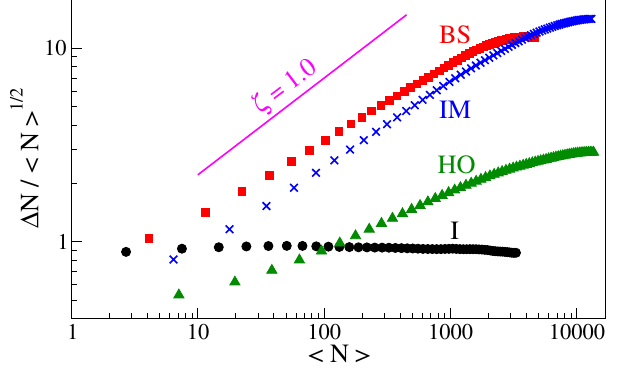
Figure 4. Density fluctuation ∆ = < > − < > N N N 2 2 . All the active ordered states show large density fluctuation obeying the relation ∆ ∼ < > ζ N N with ζ > 1/2. The active disordered isotropic state shows normal density fluctuation with ζ =